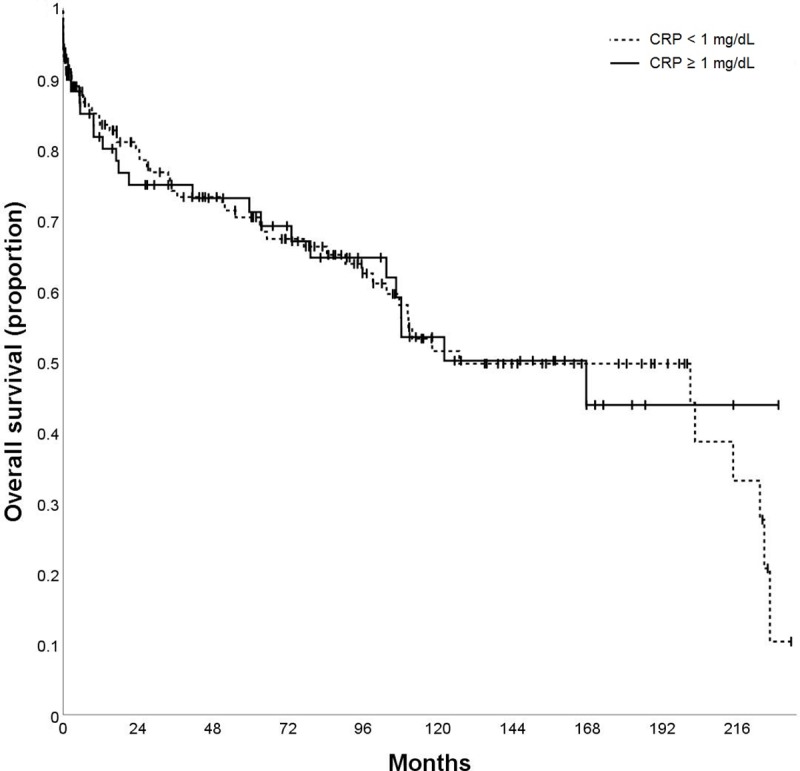
Kaplan-Meier curve according to serum C-reactive protein (CRP) level: Overall survival (OS) according to CRP ≥ 1 mg/dL vs. CRP < 1 mg/dL.